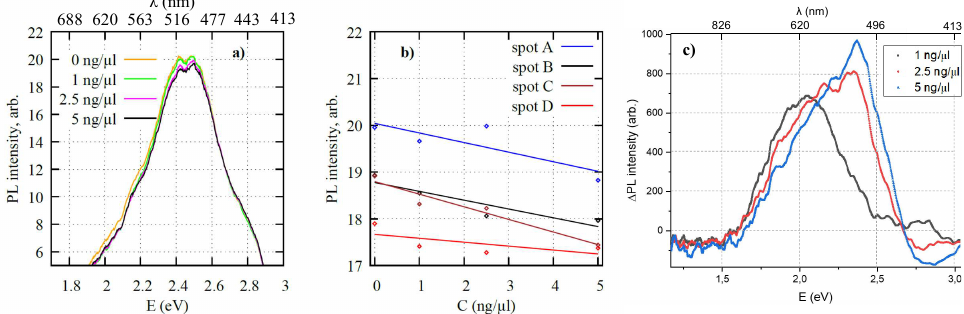
Figure 7. ( a ) Typical PL spectra of hybrid film after exposure to different concentrations C of VEGF and ( b ) green PL (2.48 eV) intensity depending on concentrations of VEGF 165 at different spots on the same sample. The Pearson correlation coefficients r of between C and PL intensity in spots A, B, C, and D was − 0.73, − 0.97, − 0.96, and − 0.79, respectively. ( c ) Difference between PL spectra of functionalized and BSA-treated sample before and after exposure to different concentrations of